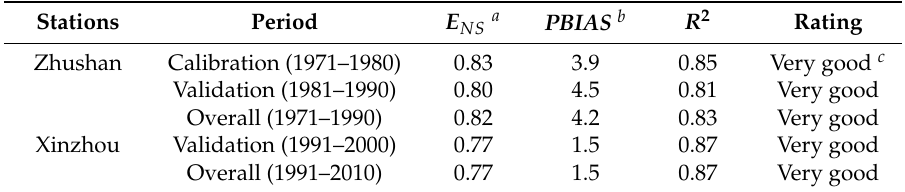
Table 2. Examination of the performance of SWAT in the Upper Du